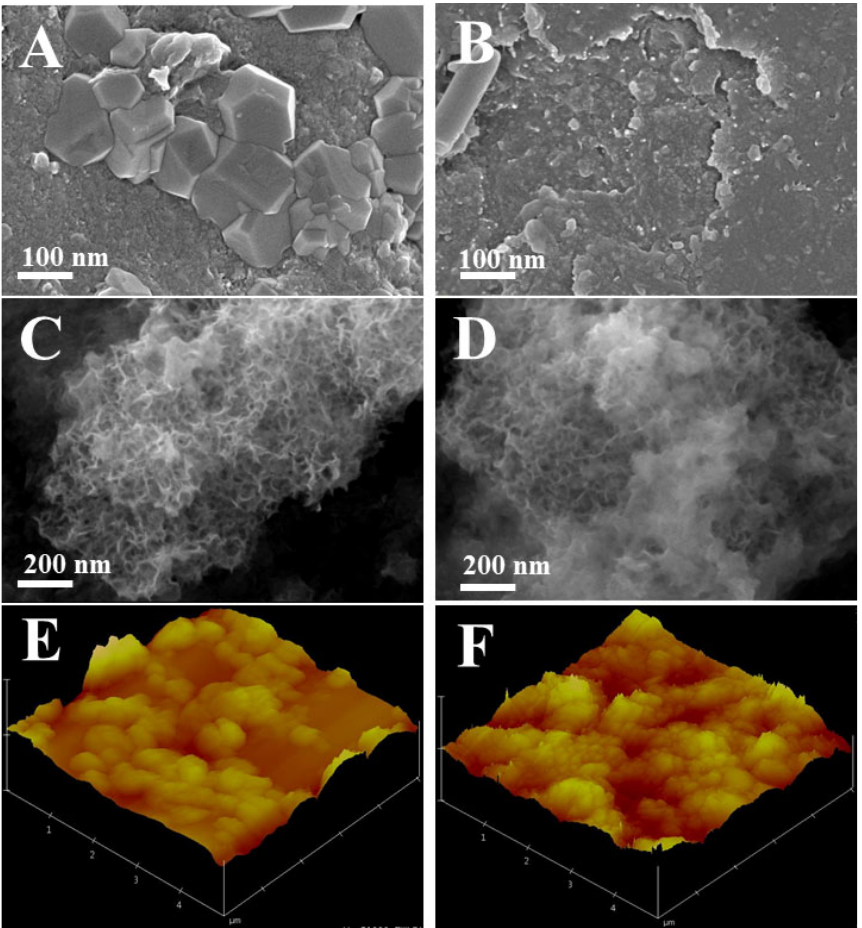
Figure 1. SEM of Co/Ni@MOF ( A ) nanododecahedron and ( B ) its MIP, ( C ) nanosheets and ( D ) its MIP, AFM 3D surface topographies of MIP ‐ Co/Ni@MOF nanosheets ( E ) before template removal and ( F ) after template